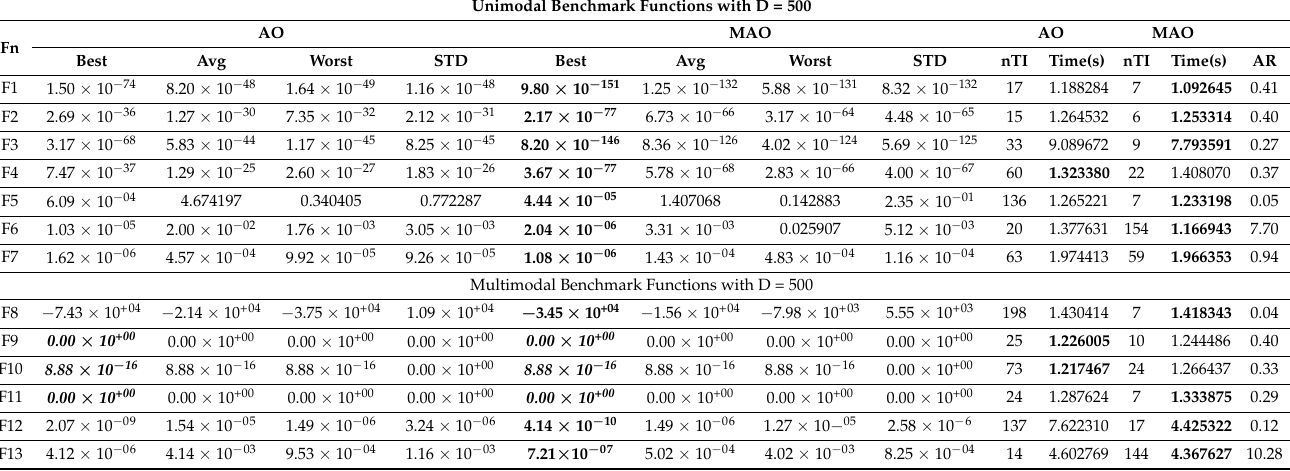
Table 8. Results obtained for unimodal and multimodal functions with D = 500. Unimodal Benchmark Functions with D =